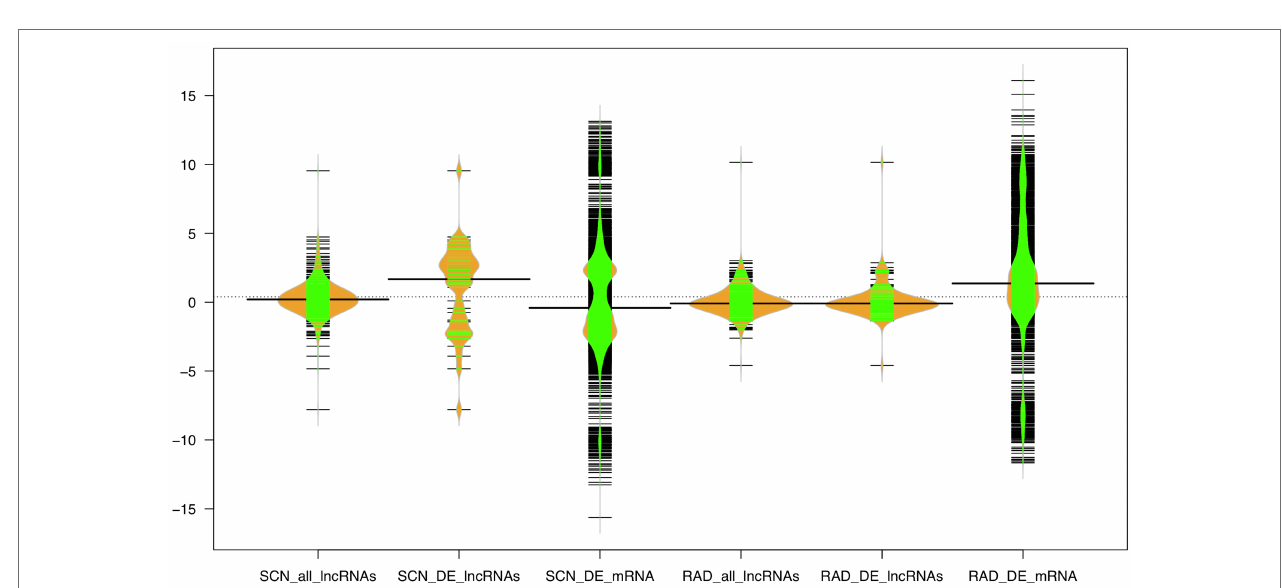
FIGURE 6 | The expression distribution of the lncRNA and mRNA transcripts under SCN and reniform infestation. The width of the bean diagram represents the density (frequency) of the transcripts under a certain logFC (expression)